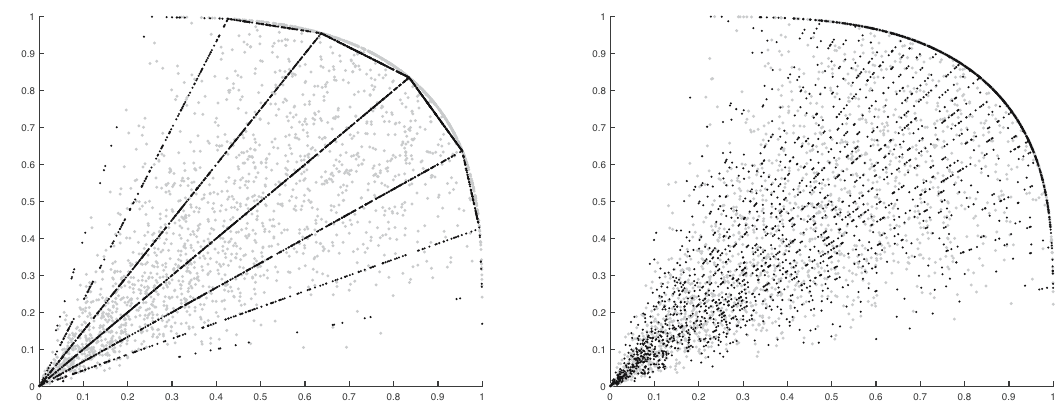
Figure 1: Scatter plot of 2,500 samples from ℓ C ˆ with ℓ given by the Hüsler - Reiss family with parameter = / θ 1 4 ( gray points ) , as well as from its approximation ℓ C ˆ n , ( black points ) with = n 10 ( left plot ) and = n 80 ( right plot